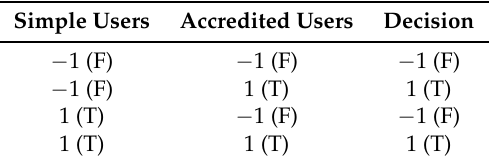
Table 2. Decision-making.